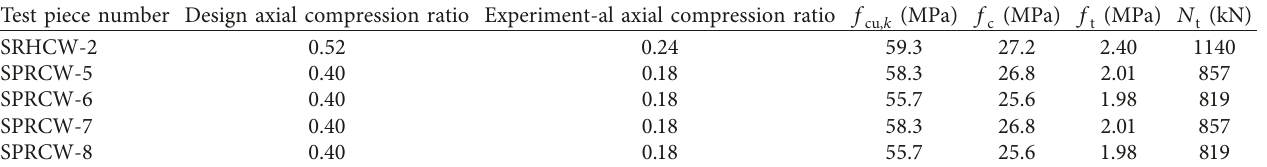
Table 4: Measured strength of concrete and vertical loads of test